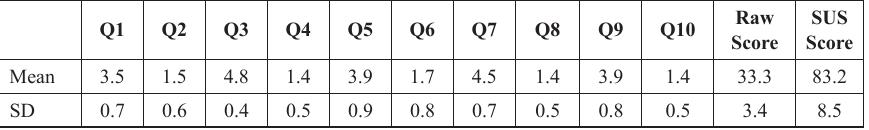
Raw SUS Score Score